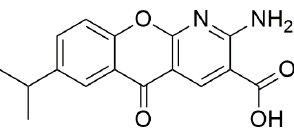
Figure 8. Structure of Amlexanox.